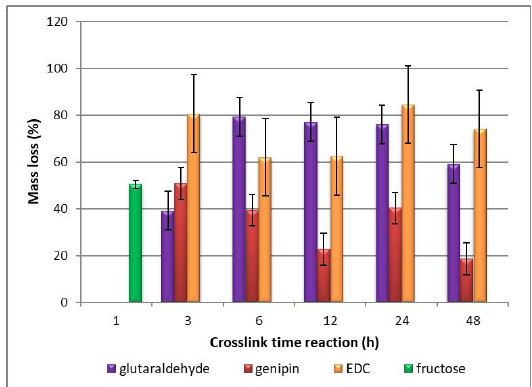
Figure 2. Enzymatic degradation of the samples.